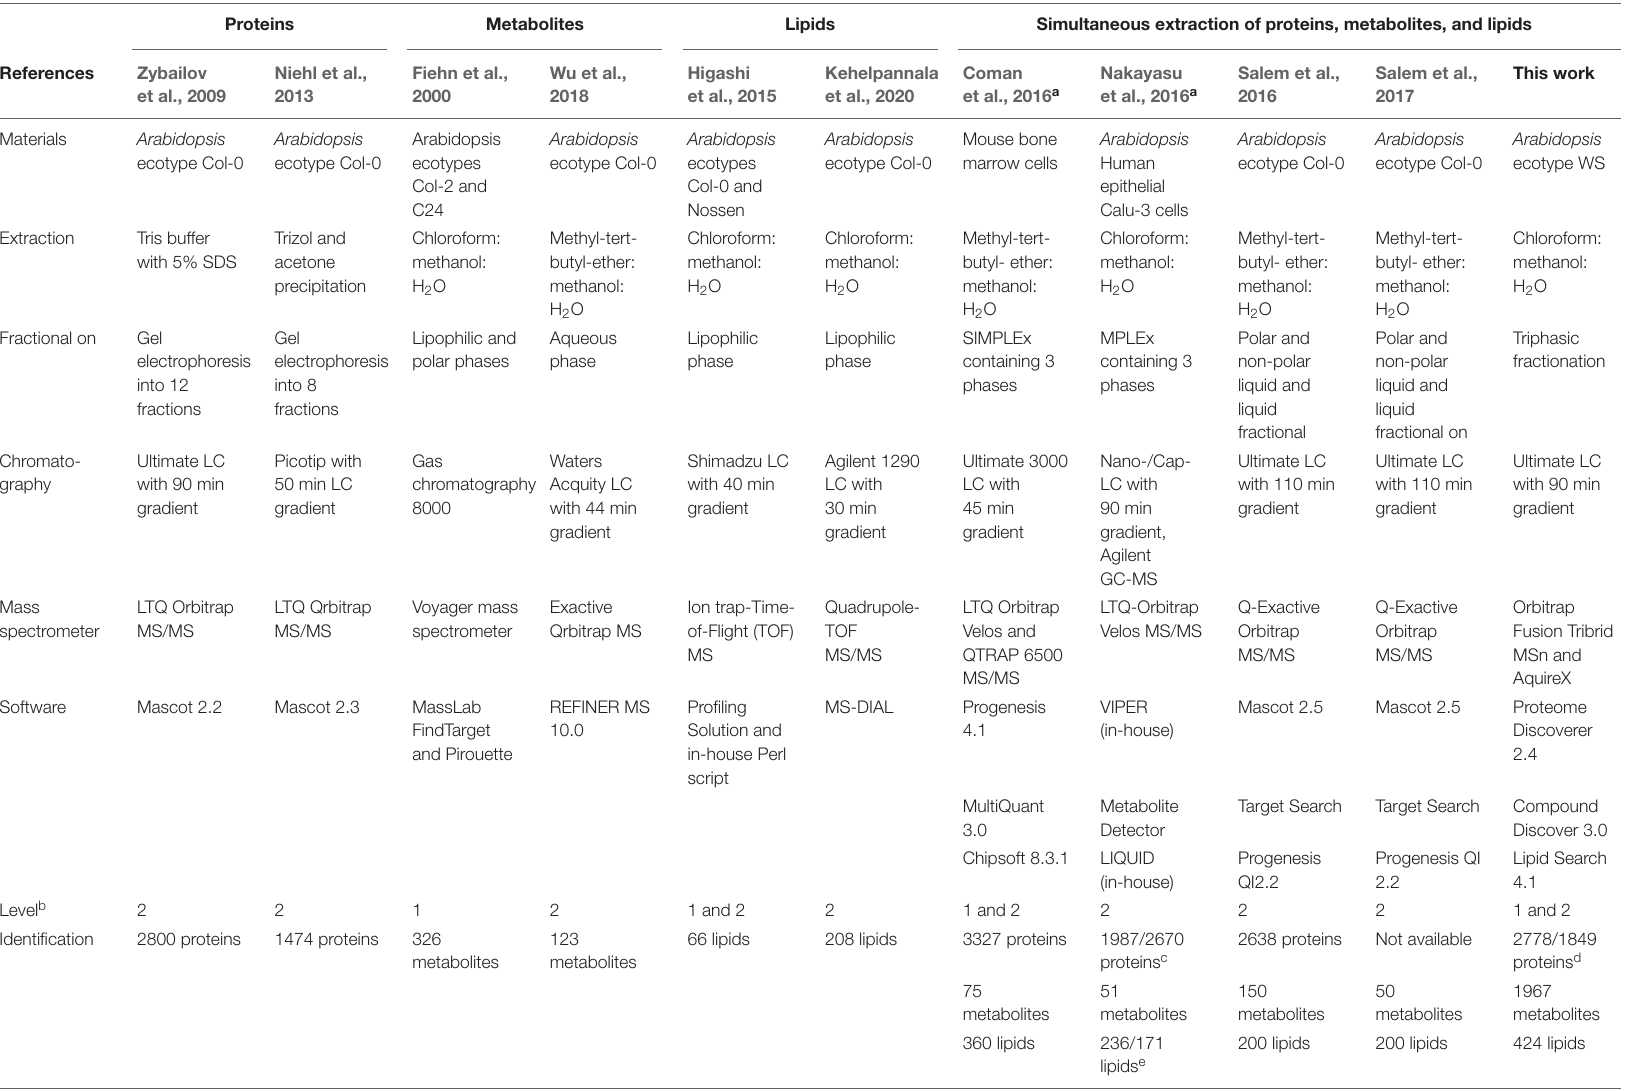
TABLE 1 | Comparison of the three-in-one method in this study with previously published targeted and three-in-one